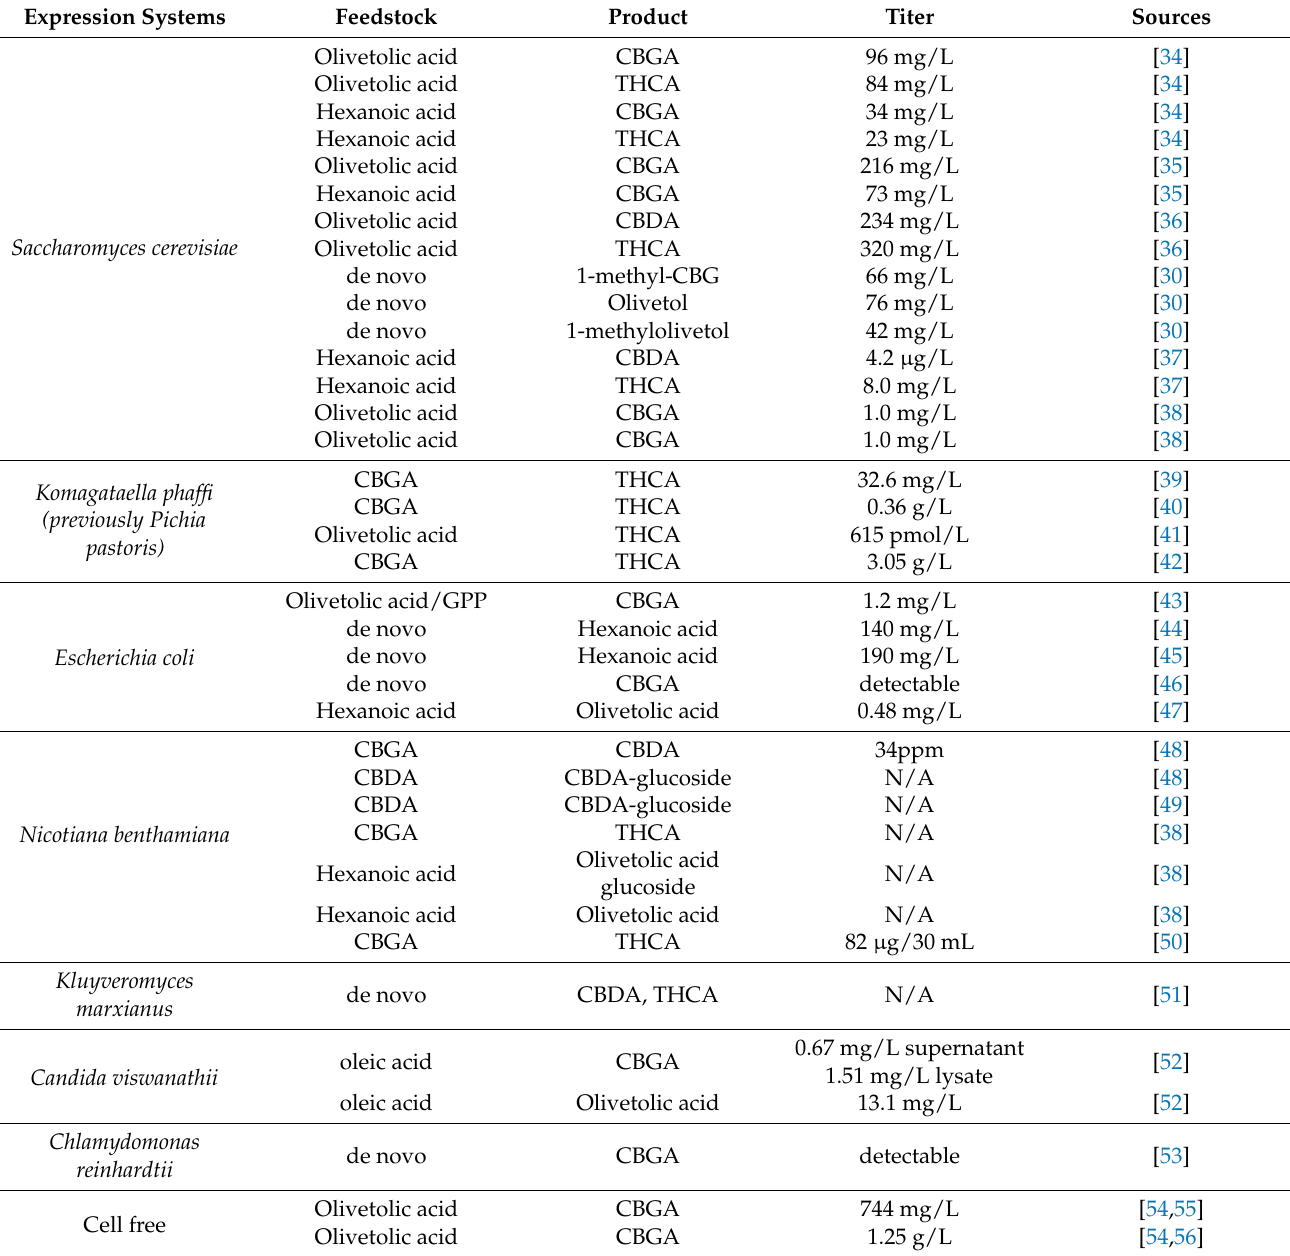
Table 1. Summarized published work of heterologous systems for cannabinoid